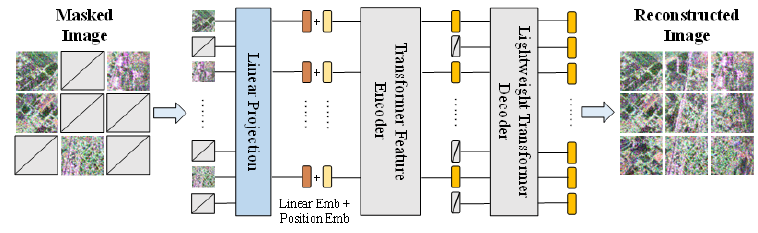
Figure 4. The pre-training method of the proposed classification